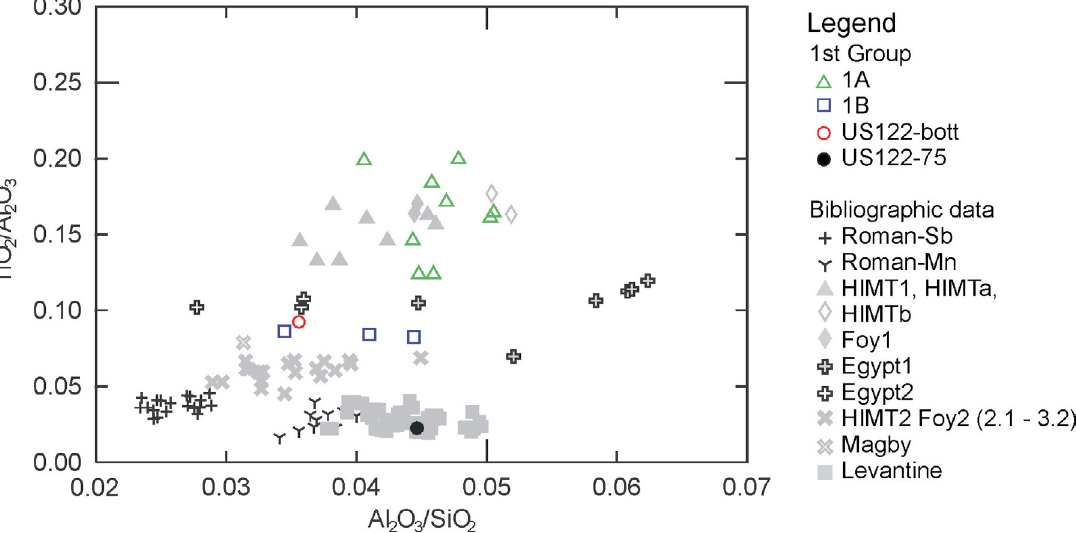
O /SiO vs. TiO /Al O for the samples of the first group. 2 3 2 2 2 3